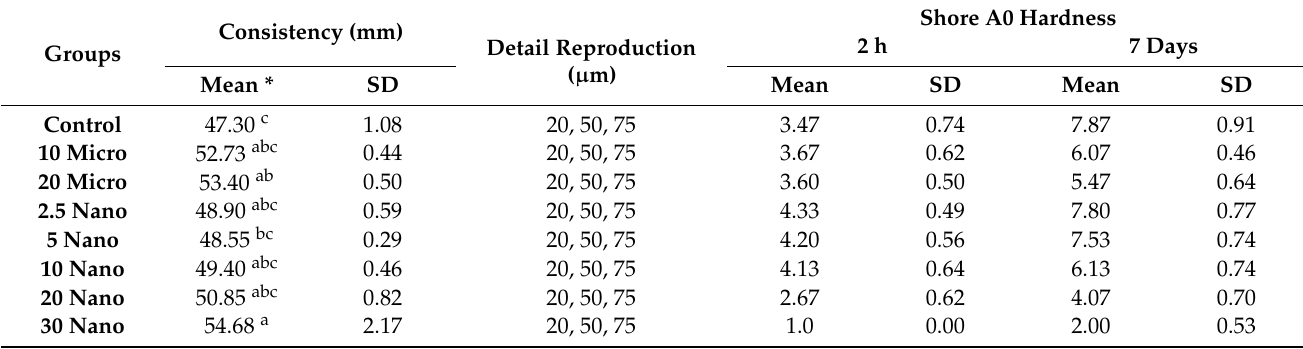
Table 3. Consistency, detail reproduction, and Shore A0 hardness of various tissue conditioners.